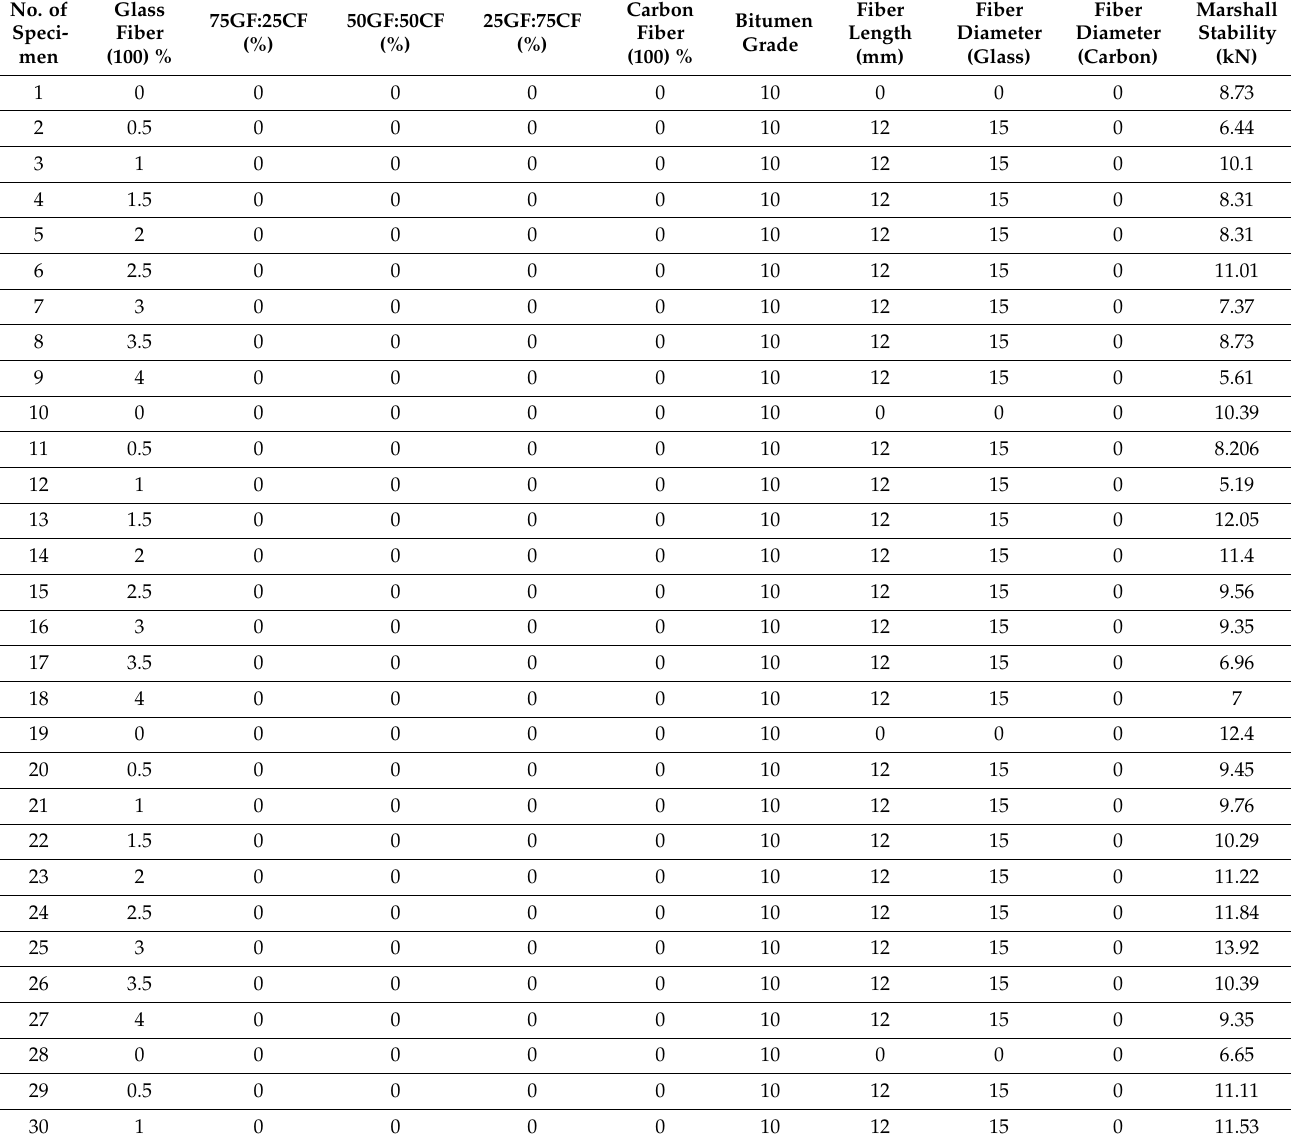
Table 8. Experimental